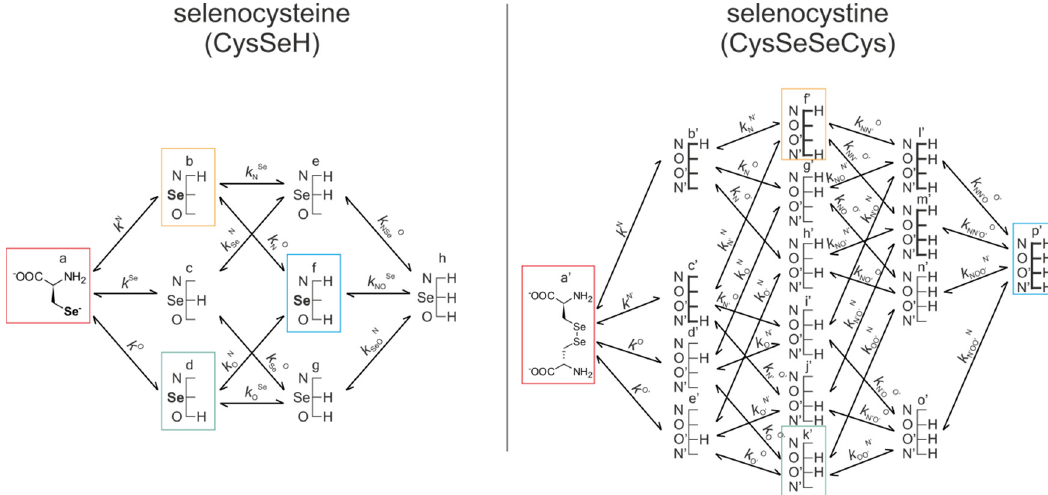
Figure 5. The protonation microequilibrium schemes of selenocysteine (left) and selenocystine (right). For simplicity, not every protonation microspecies is shown in a structural formula, rather a schematic structure depicts the microspecies with its basic sites where N, Se, and O labels denote the amino, selenolate, and carboxylate groups, respectively. The corresponding species participating in redox equilibria are bordered in